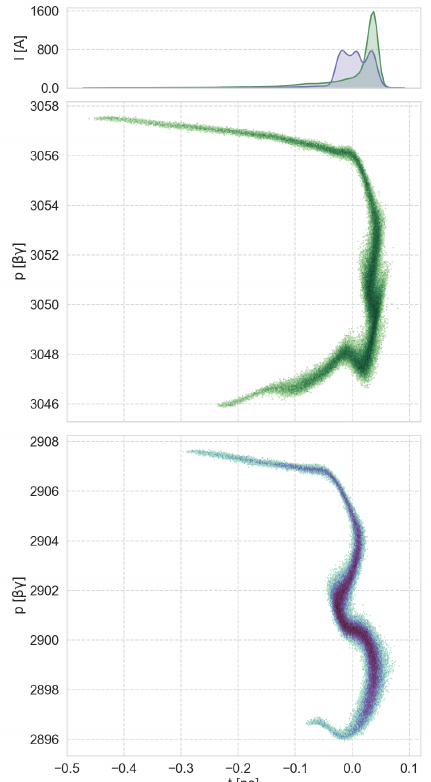
Figure 4. LPS at the BAC exit. In green the case where the CSR effect is pre-compensated by the HHL, in blue a test case with the HHL turned off. On top of the image the relative current